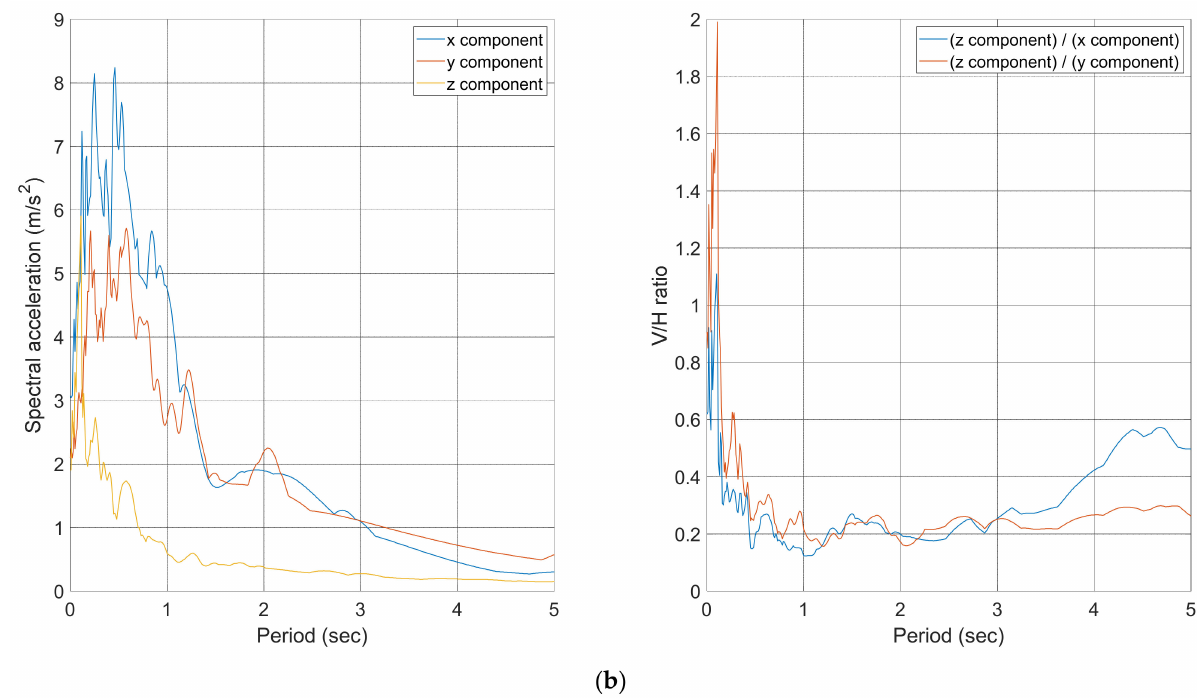
.. .. .. u 0 gx ( t ) , u 0 gy ( t ) , and u 0 gz ( t ) ; ( b ) response spectra and the